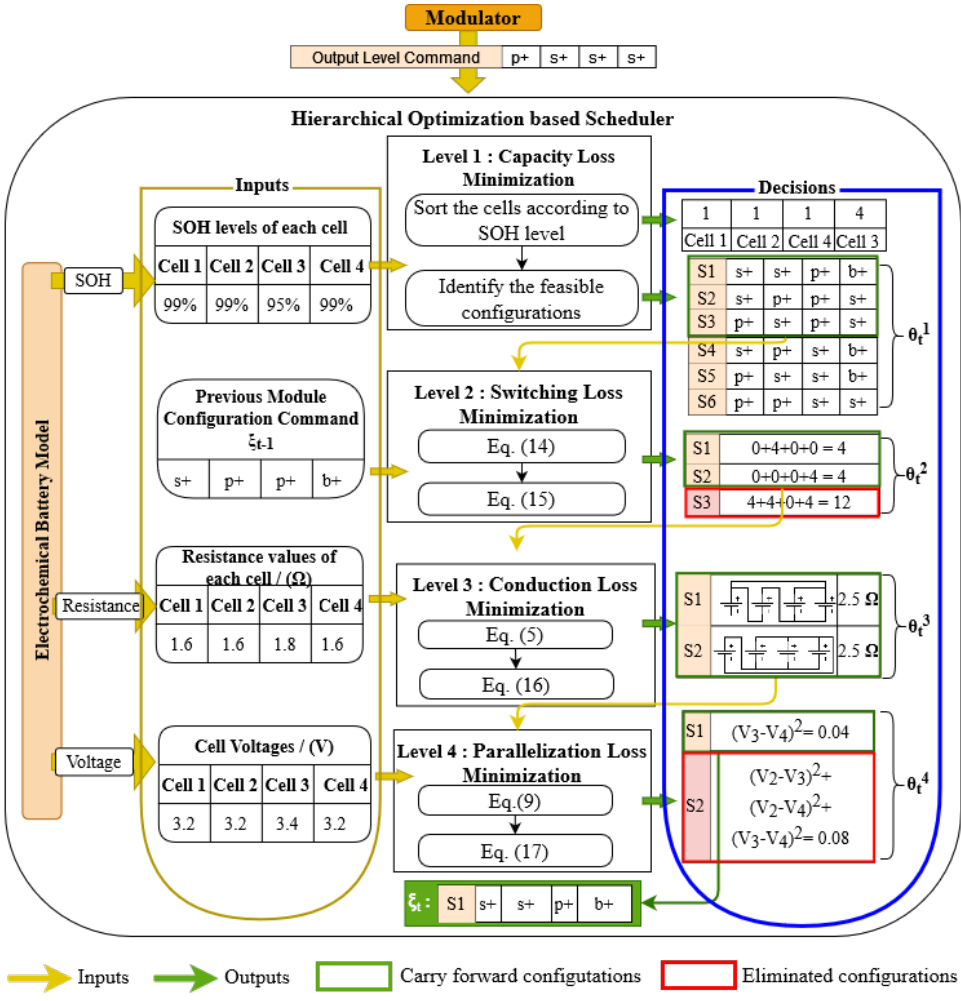
Figure 6. An example flow diagram for the proposed hierarchical